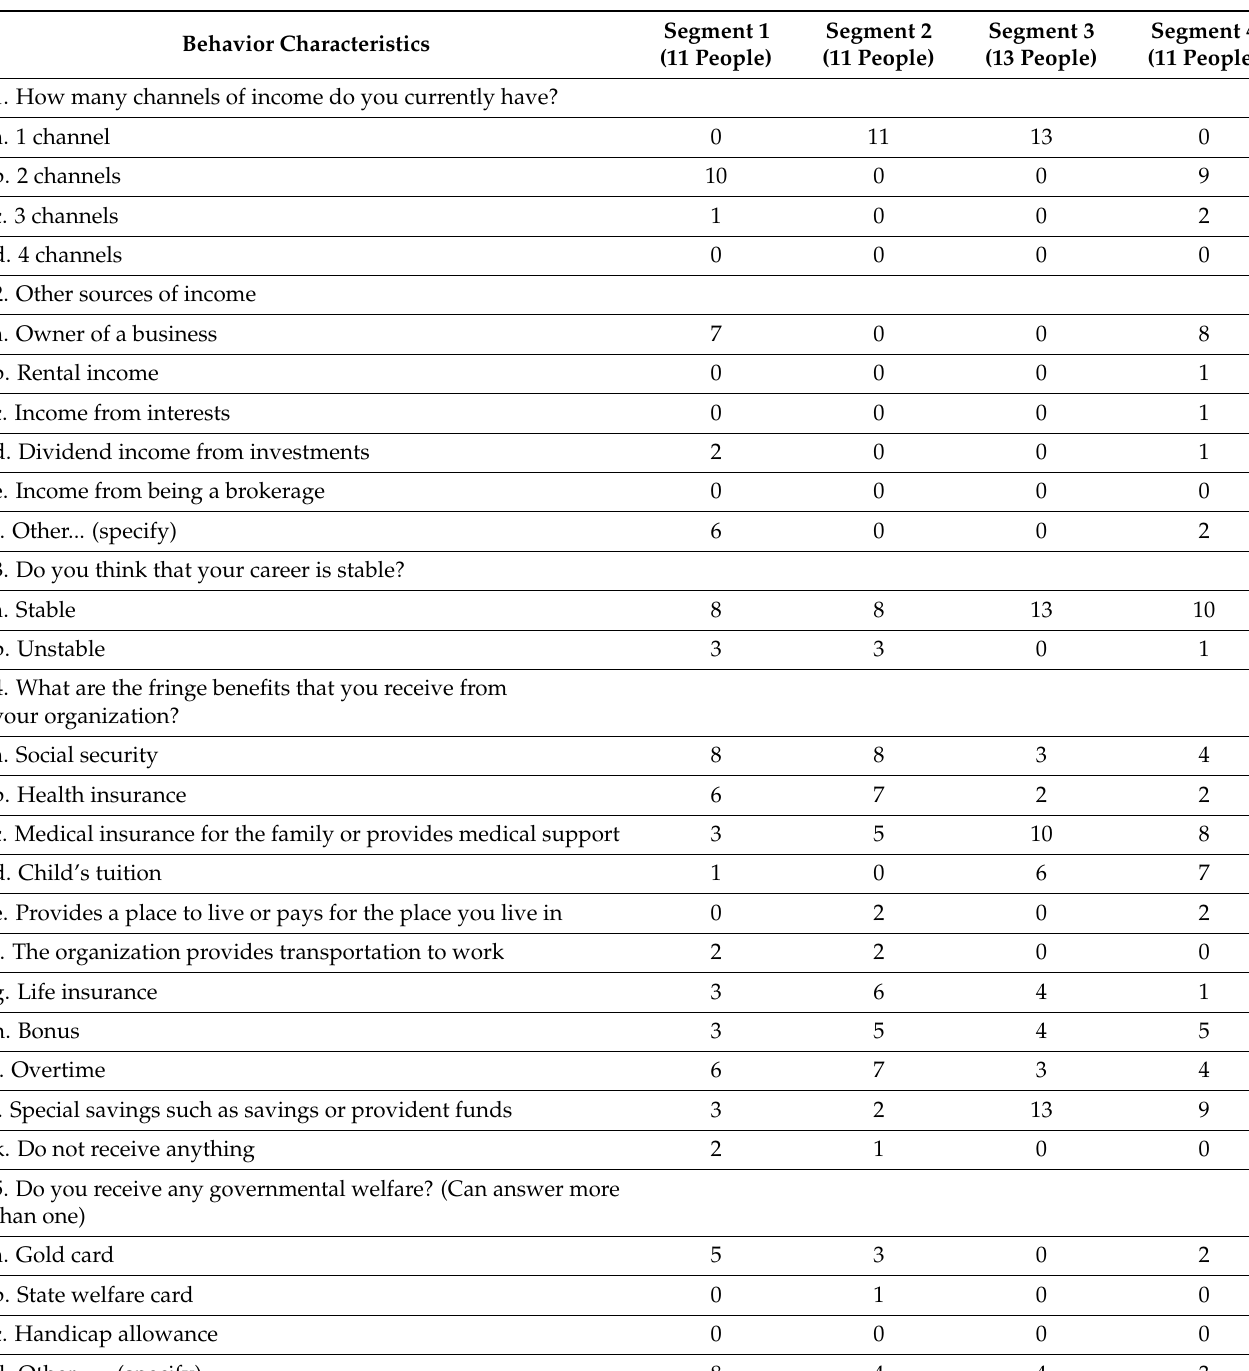
Table 2. Characteristics of interviewees’